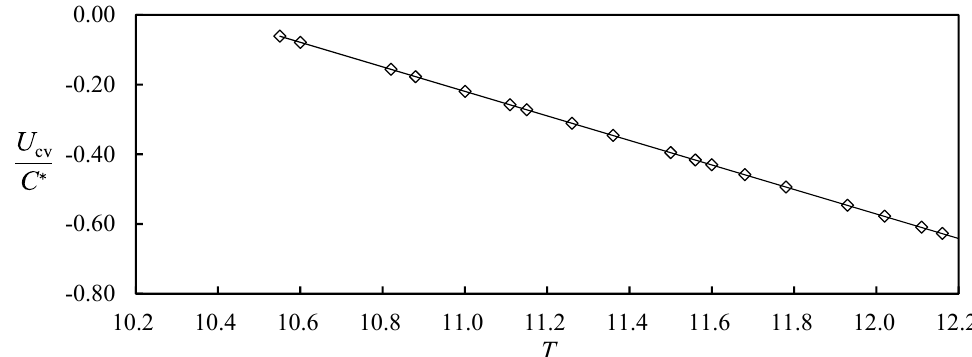
Figure 20. Variation of the non-dimensional convection velocity of the primary vortex core, U cv / C *, with the non-dimensional time, T .